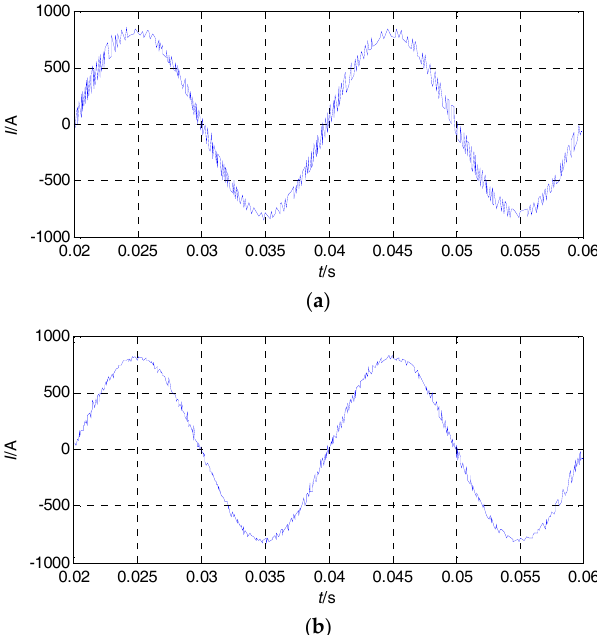
Figure 6. The simulation results of AC current: ( a ) Traditional control strategy; ( b ) The strategy proposed in this paper.